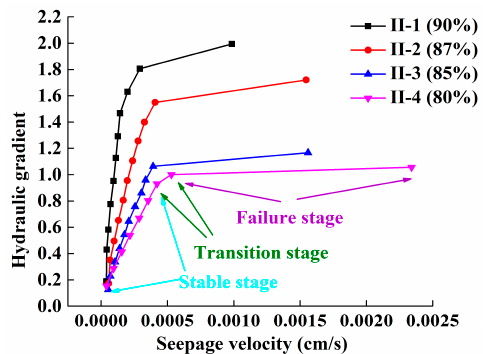
Figure 6. Hydraulic gradient–seepage velocity curves under different degrees of compaction.